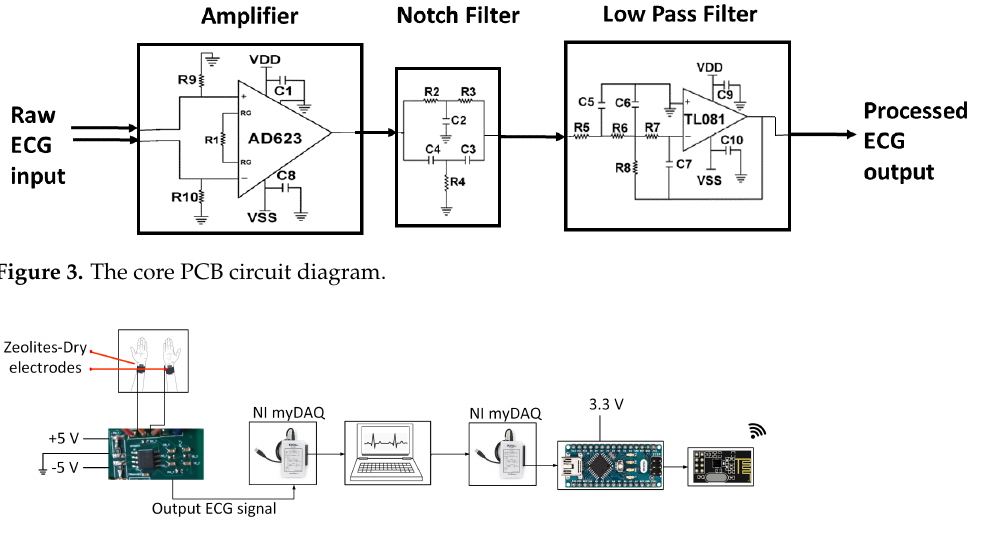
Figure 4. Experimental setup for ECG wireless